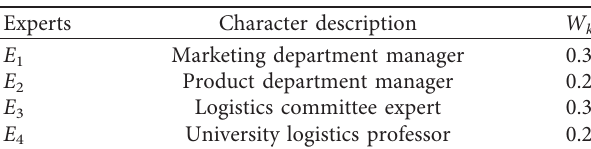
Table 4: Expert information